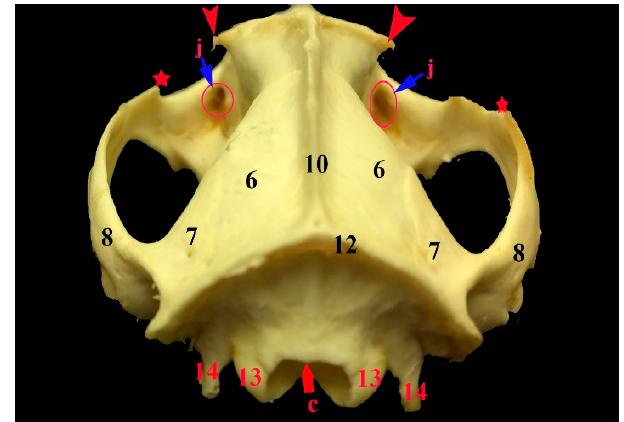
Figure 5. Photograph showing the nuchal surface of the occipital bone of the common opossum. 6. parietal bone; 7. squamosal bone; 8. zygomatic process of squamosal bone; 9. zygomatic bone; 10. external sagittal crest; 12. nuchal crest; 13. occipital condyle; 14. jugular process; arrow head: zygomatic process of frontal bone; star: frontal process of zygomatic bone; circle: temporal process of zygomatic bone; c. foramen magnum; j. maxillary foramen; k. sphenopalatine foramen; l. orbital fissure; and, m. round.